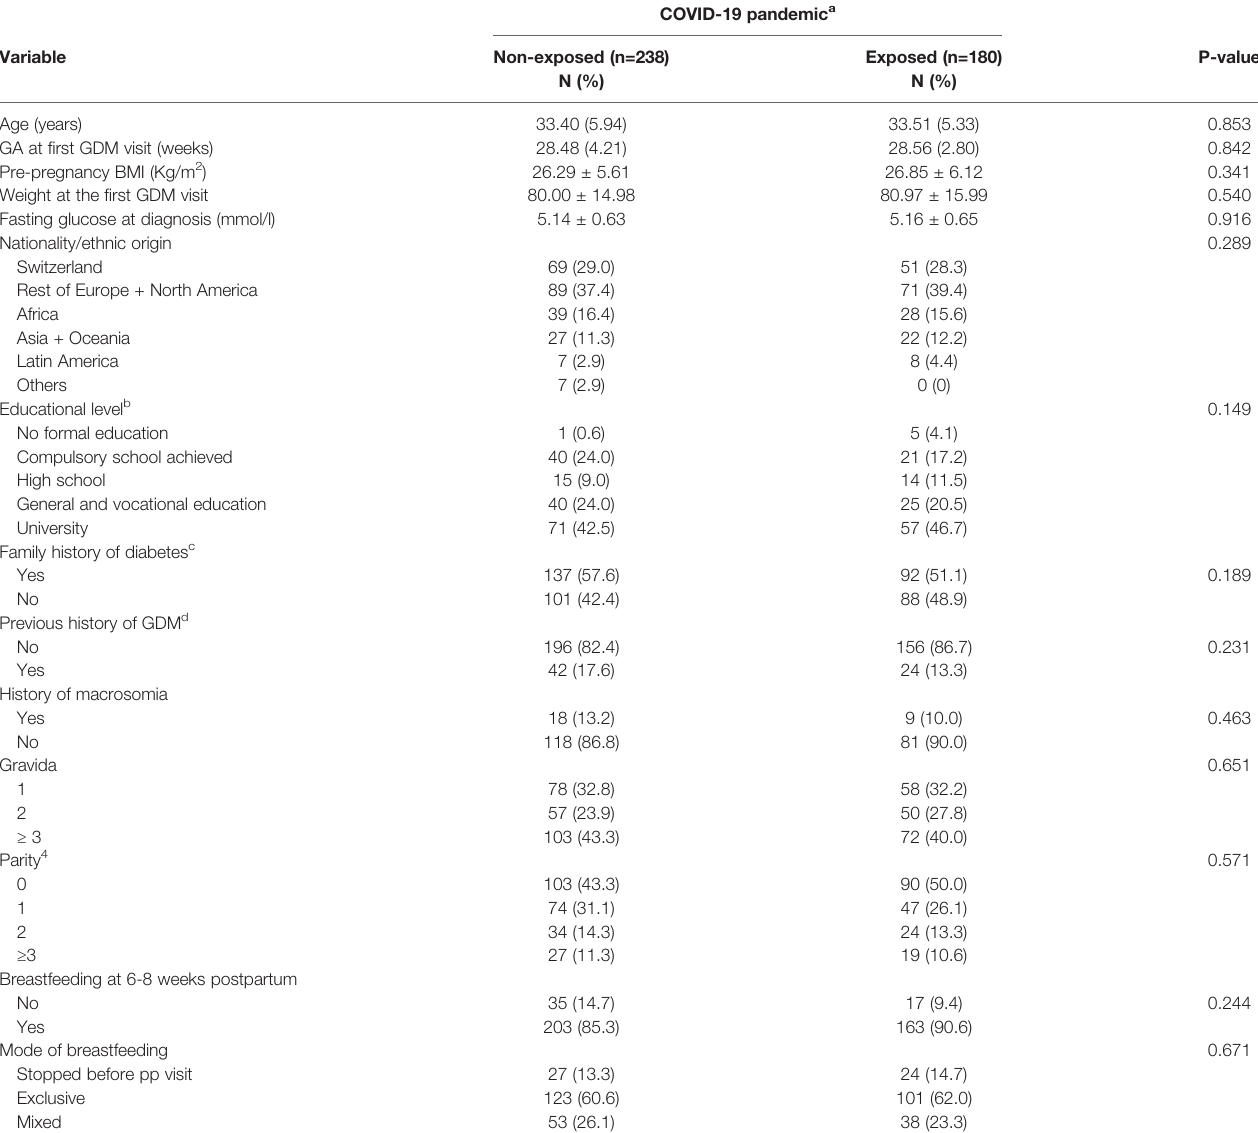
TABLE 1 | Sociodemographic and medical characteristics of participants a year before and during the COVID-19